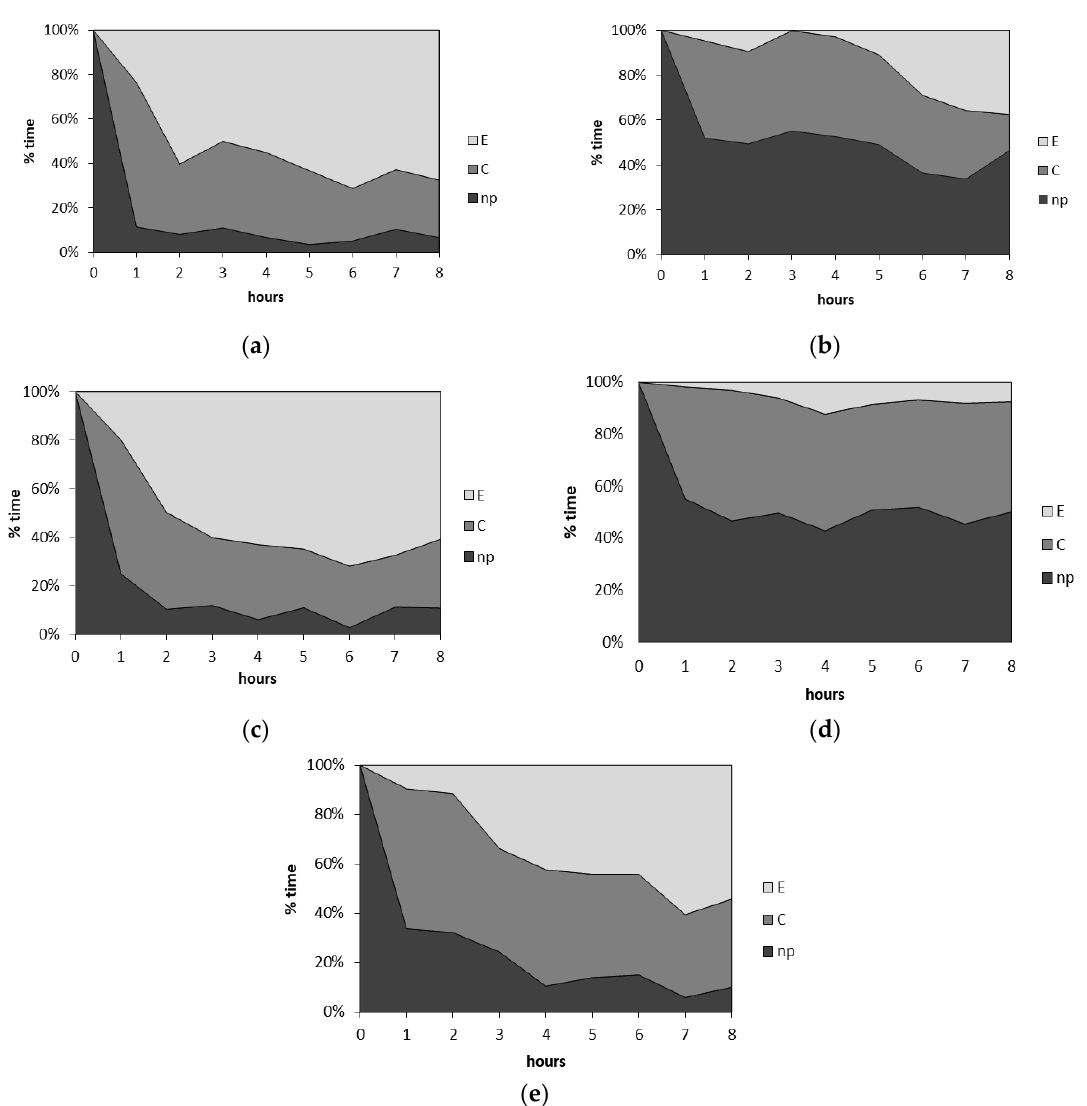
Figure 4. Sequential changes in Myzus persicae probing activity on Brassica rapa subsp. pekinensis on ( a ) control plants and plants treated with ( b ) citral, ( c ) β , γ -dimethyllactone ( 4 ), ( d ) α -methylenelactone ( 5 ), and ( e ) α , γ -dimethylenelactone ( 7 ) during the 8 h EPG monitoring of aphid probing. np—non-probing, C—aphid stylet activities in non-phloem tissues, E—aphid stylet activities in phloem tissues.